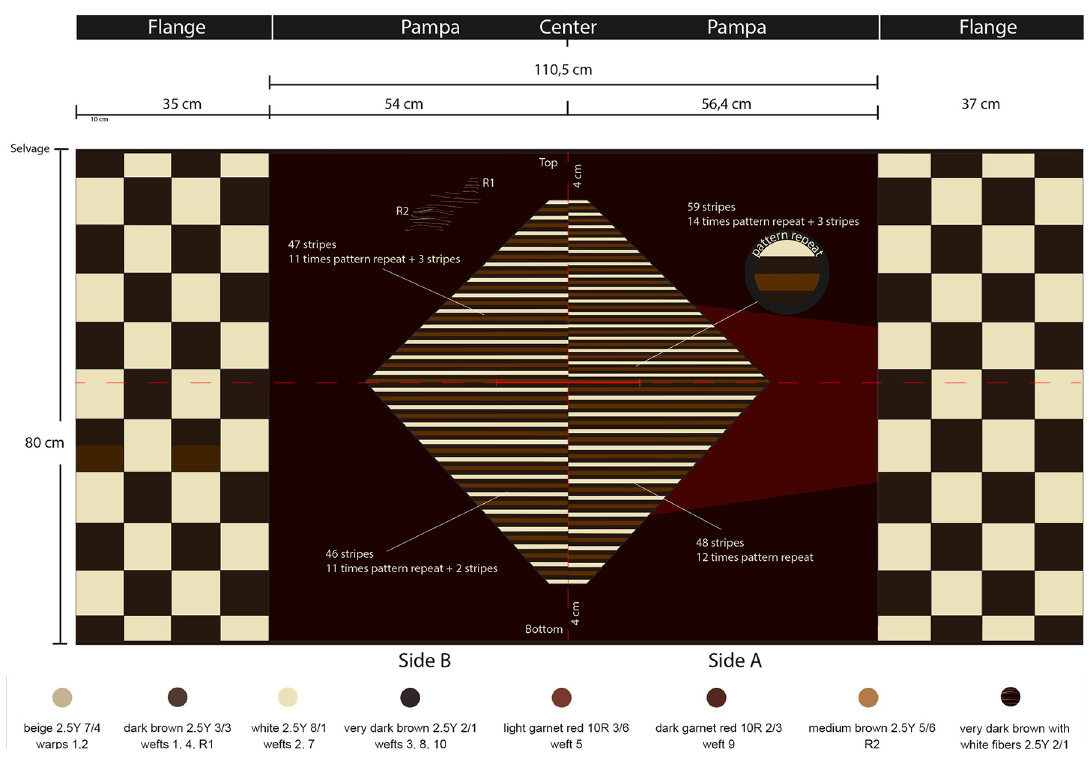
Fig 5. Description and detail of the CV unku (illustration by Pamela